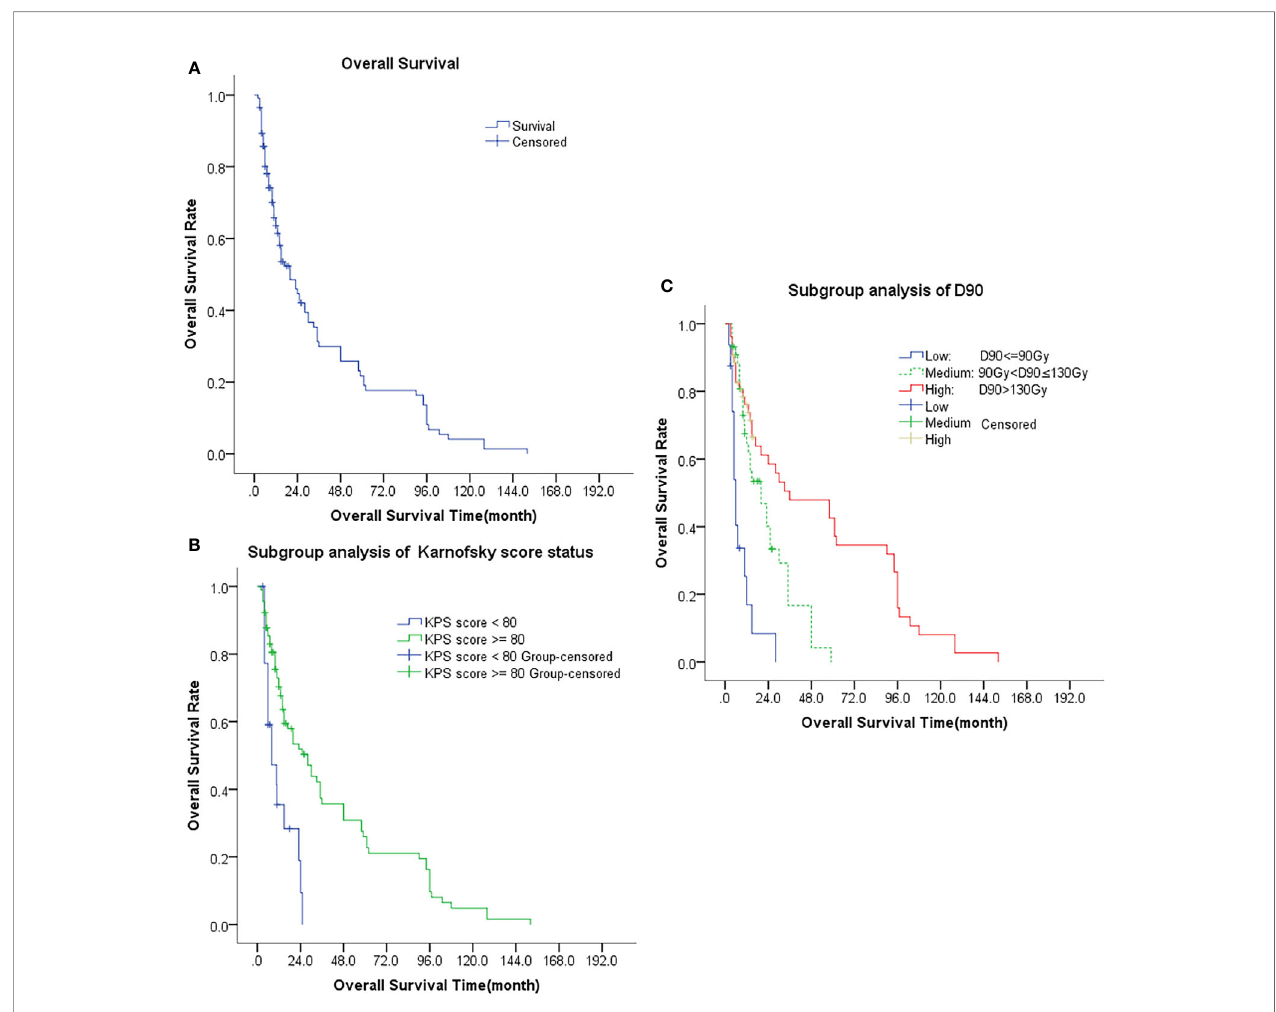
FIGURE 3 | Kaplan-Meier plots of overall survival curves; (A) Analysis of all patients; (B) Subgroup analysis of KPS (KPS < 80 and KPS ≥ 80); (C) Subgroup analysis of D90 (D90 ≤ 90Gy, 90Gy < D90 ≤ 130Gy, and D90 > 130Gy).